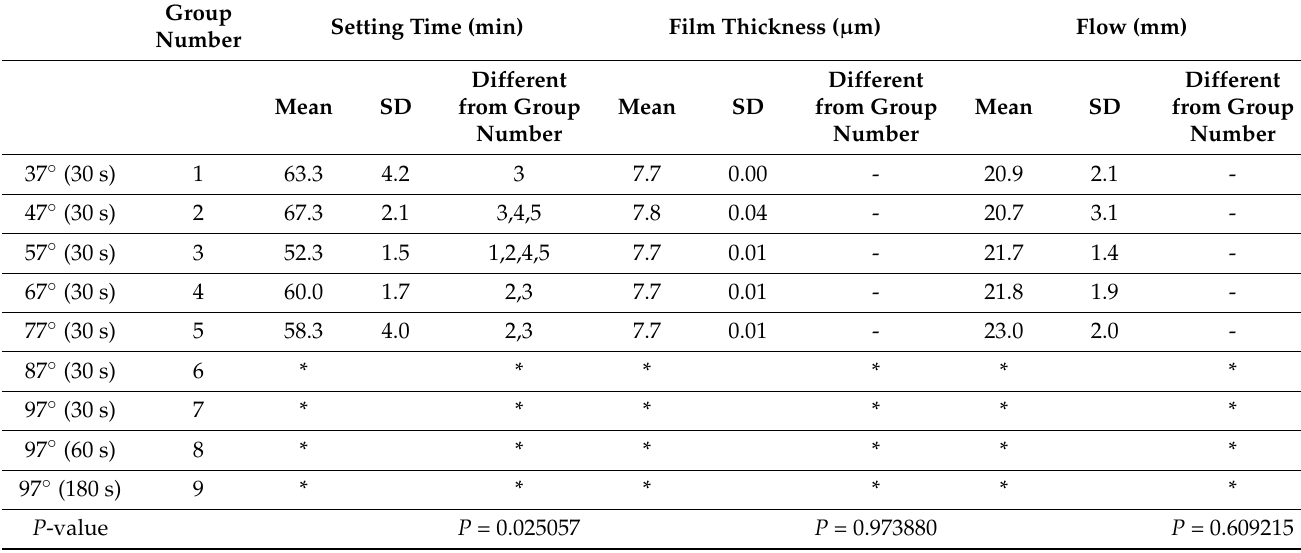
Table 2. Physical properties in accordance with ISO 6876:2012 of BioRoot RCS (means and standard deviations (SD)) after thermal treatment. Statistical analysis of setting time, film thickness and flow for BioRoot RCS was performed by Kruskal-Wallis-Test ( P = 0.05).